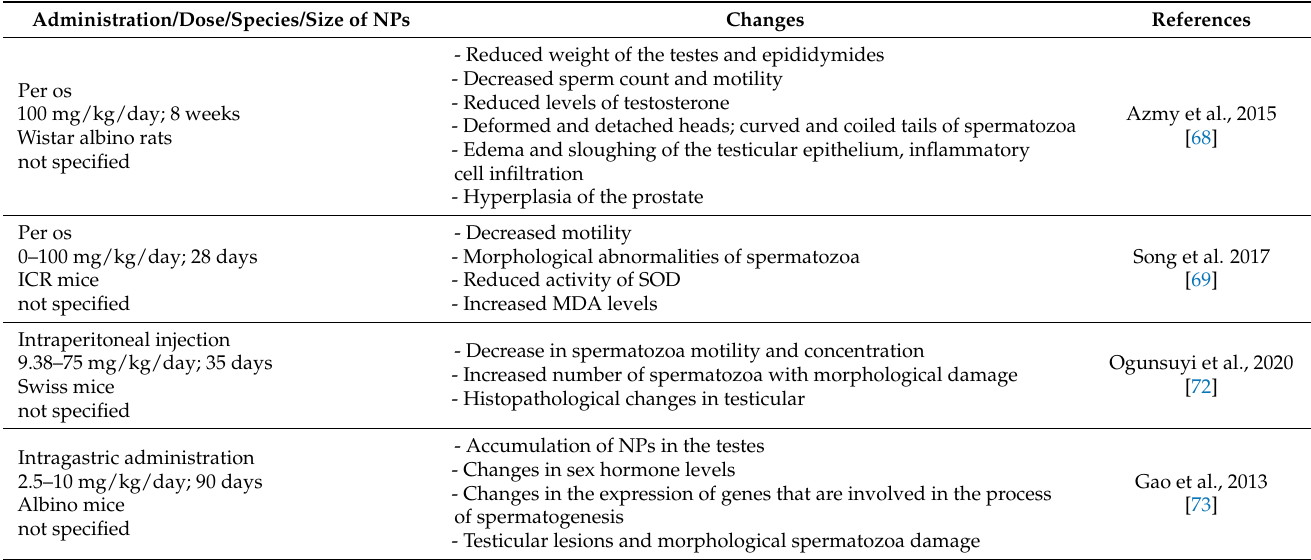
Table 5. Alterations in the male reproductive system caused by TiO 2